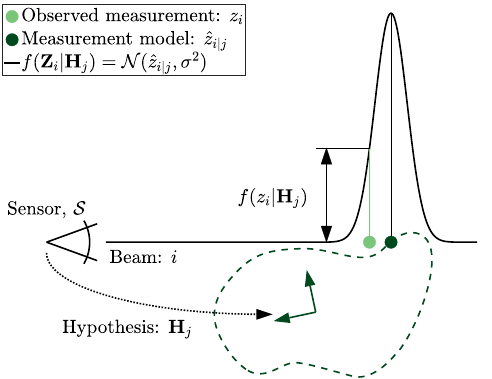
Figure 5. Range likelihood distribution, f ( Z i | H j ) , given sensor measurement uncertainty, σ